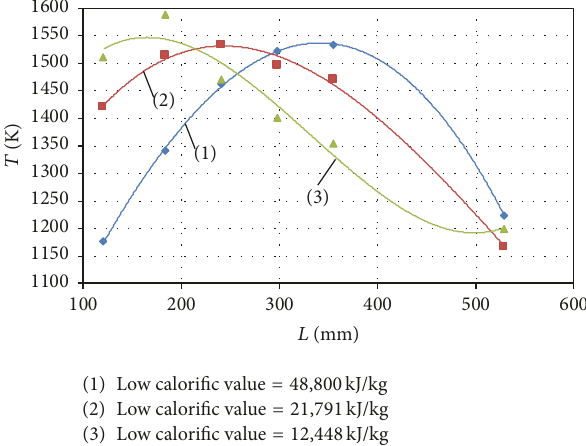
Figure 7: Change of average mass temperature ( 𝑇 ) along the length ( 𝐿 ) of the